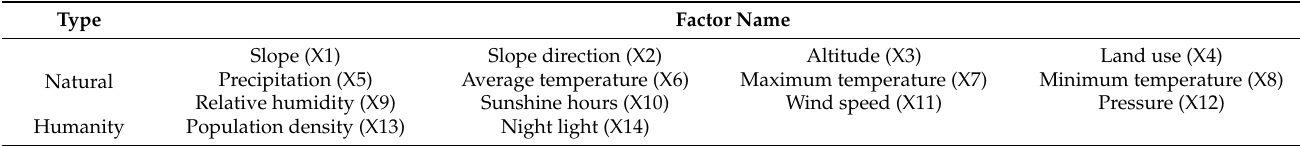
Table 2. Selection of